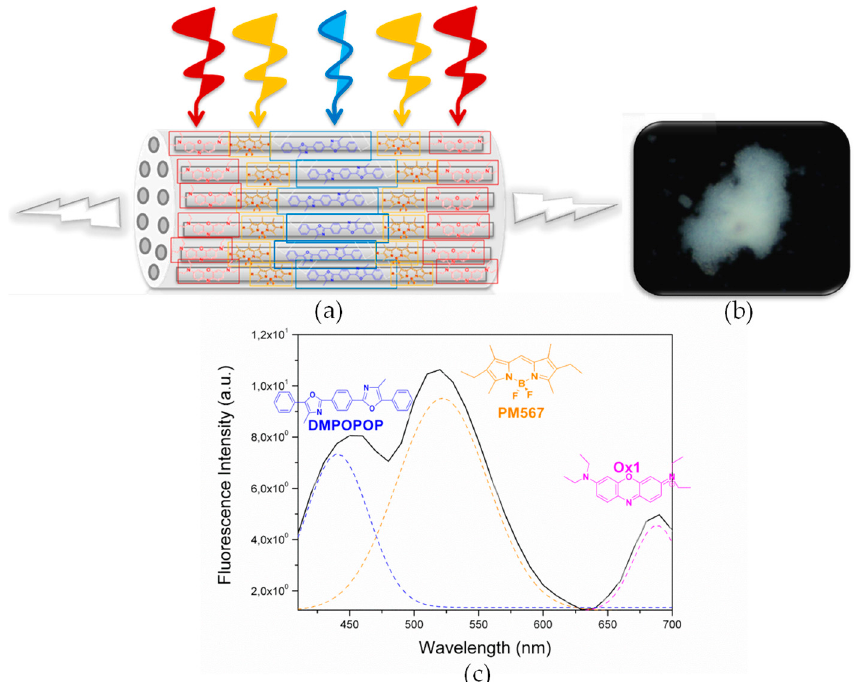
(Table 1). After selective excitation at the UV region, where just the first energy donor (Dmpopop) absorbs, its own emission is recorded but followed by that from PM567 and the last energy acceptor Ox1 emission band (Figure 4). Therefore, this hybrid material undergoes FRET (see spectral overlap in Figure S1, which enables through-space FRET) as red emission is attained upon excitation far away from the long-wavelength absorption of oxazines, but partial, since the emission from the donors is not completely quenched and the corresponding fluorescence of each chromophore is simultaneously detected. Nonetheless, the sum of all of these emissions covering the whole visible spectrum leads to white-light emission (Figure 4) in which the energy output can be finely tuned over a broad region just using suitable filters [33,34].